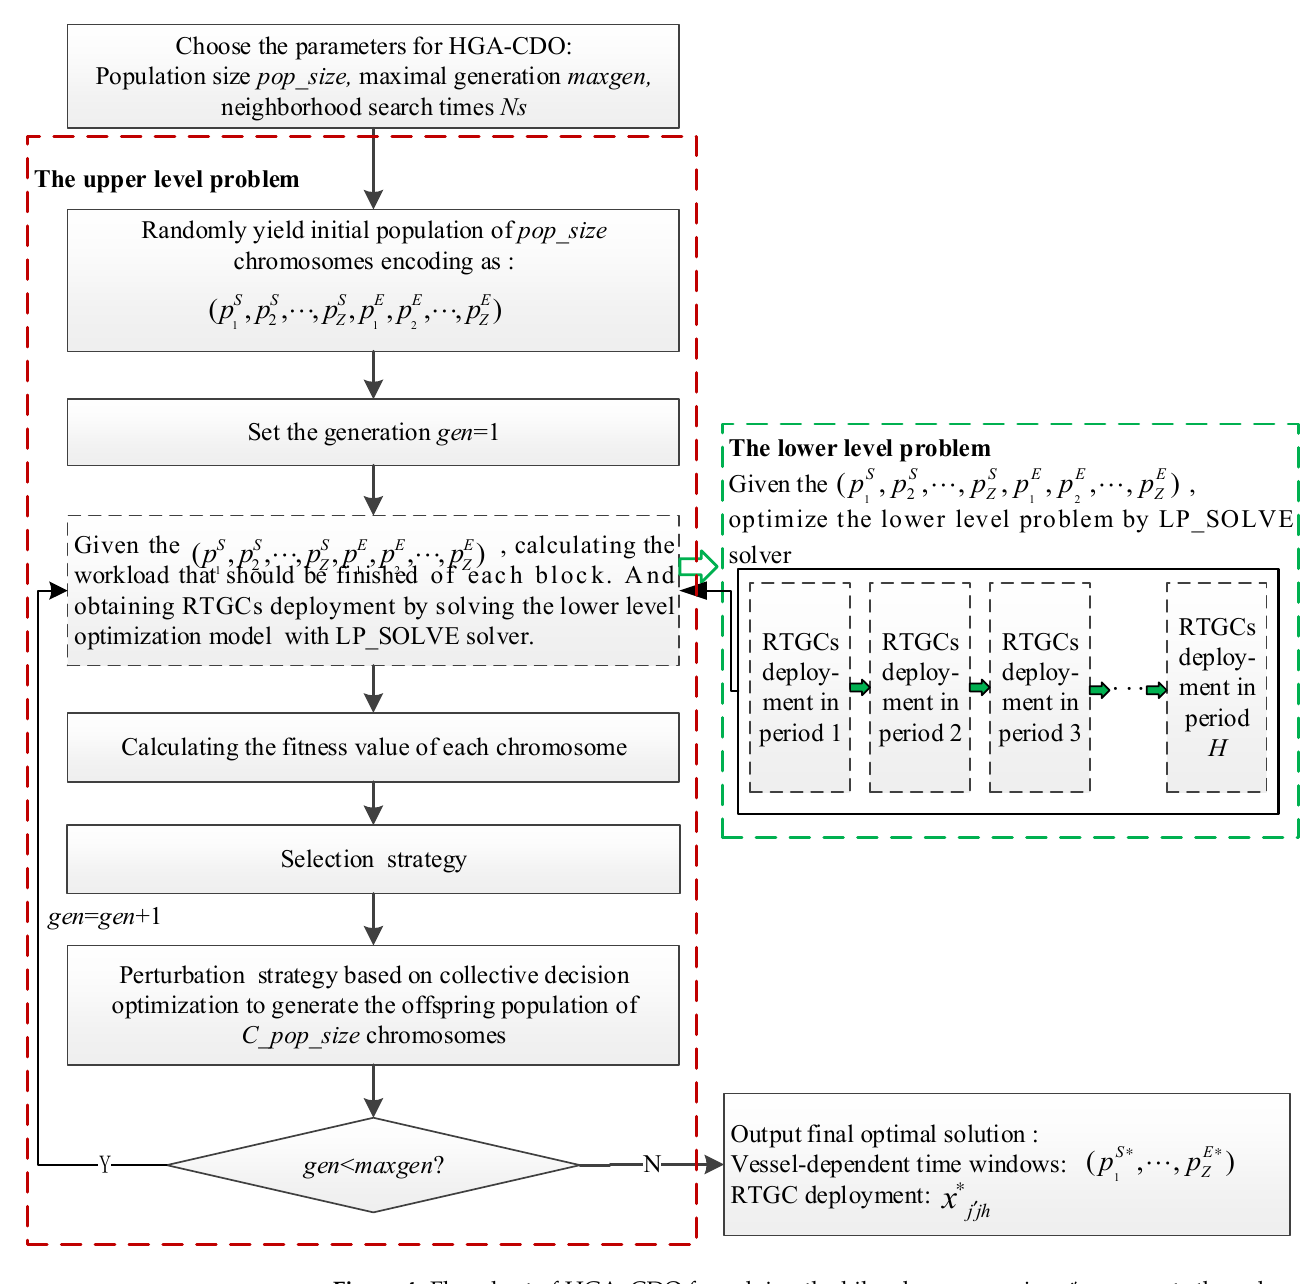
Figure 4. Flowchart of HGA–CDO for solving the bilevel programming. * represents the value of decision variable in the optimal solution.